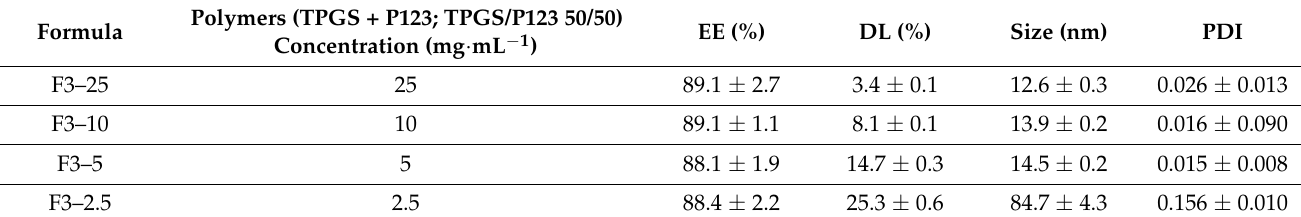
Table 3. Effect of polymer-to-drug ratio on micelle properties.